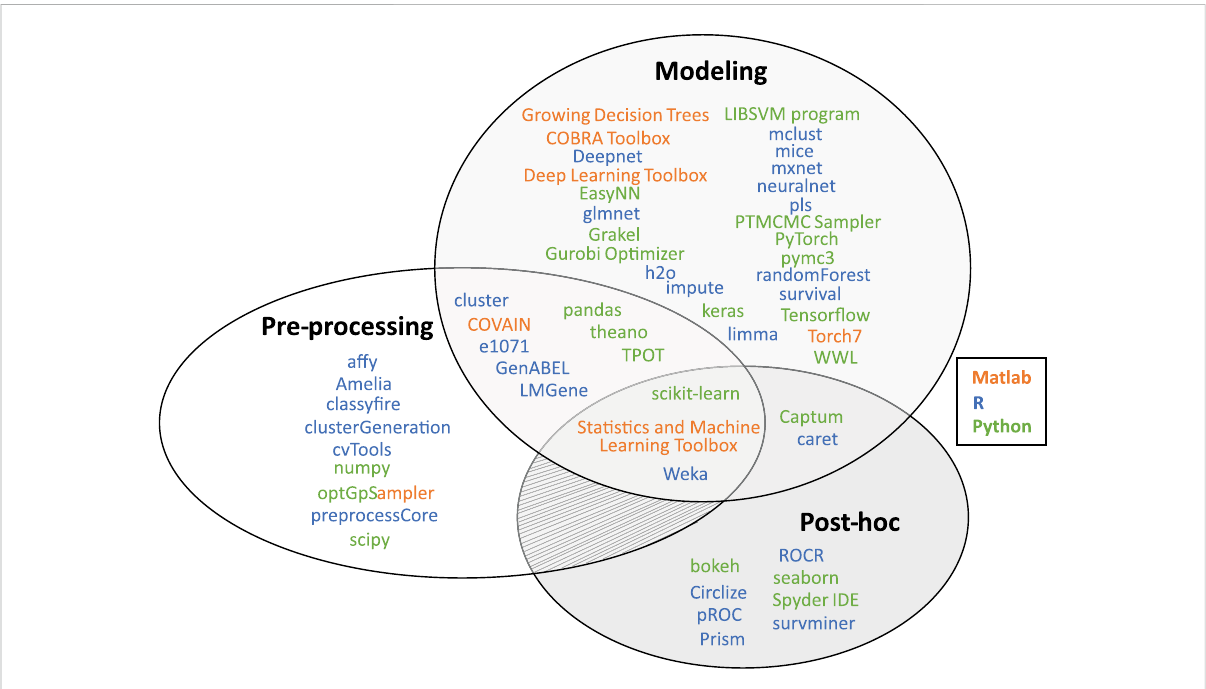
S1forreferences).Mostpackagesfocusoneitherdatapre-processing, themodeling phase(i.e.,model-basedinterpretations anddesigning, training or executing a ML model in general), or the post-hoc analysis phase (i.e., post-hoc interpretations and data